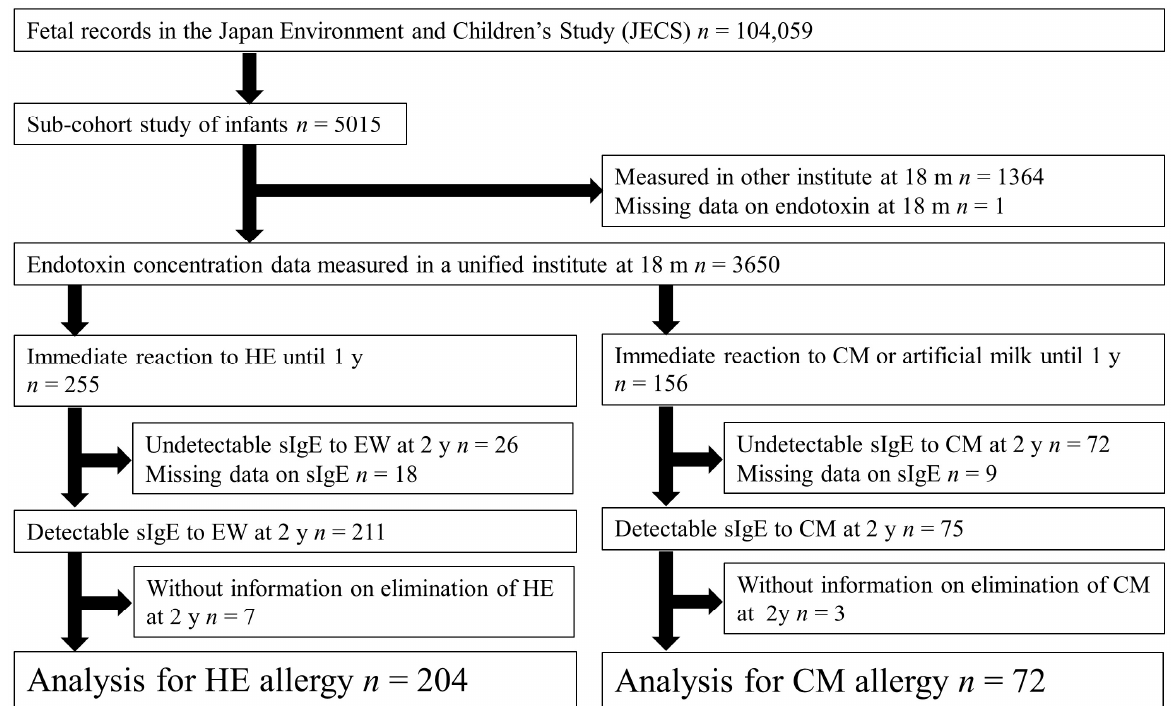
Figure 1. Flowchart of participant inclusion in this study.